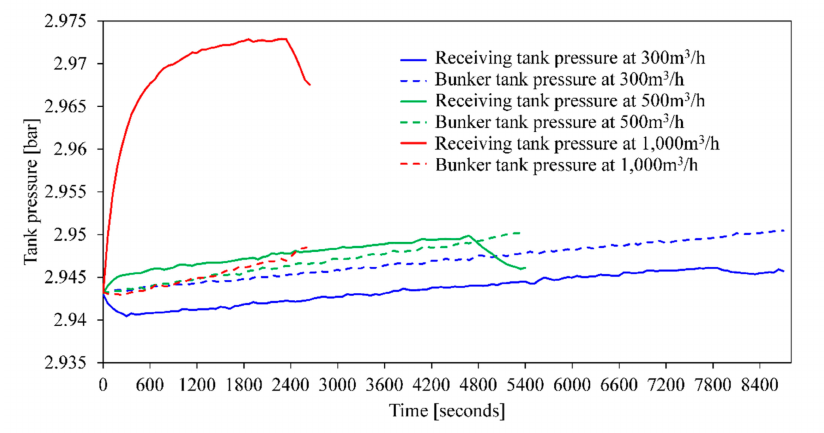
Figure 7. Variation of tank pressure at bunkering flow rates of 300, 500, and 1000 m 3 / h.